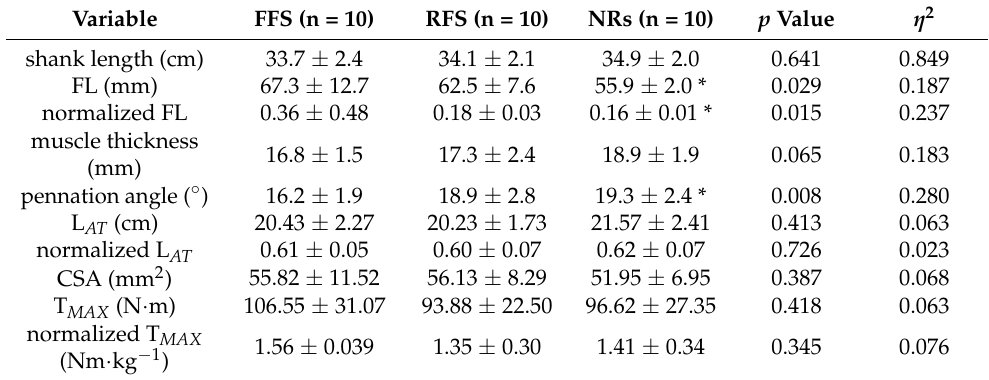
Table 2. The morphological differences in MG and AT under different habitual foot strike patterns. Variable FFS (n =